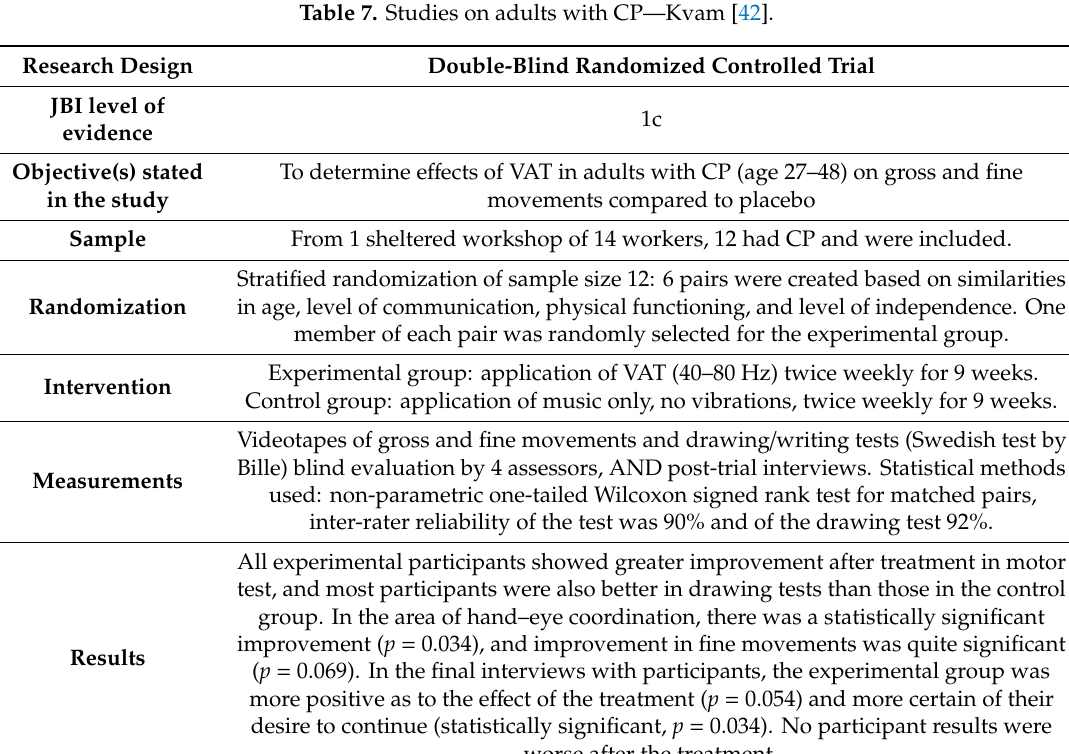
Table 7. Studies on adults with CP—Kvam